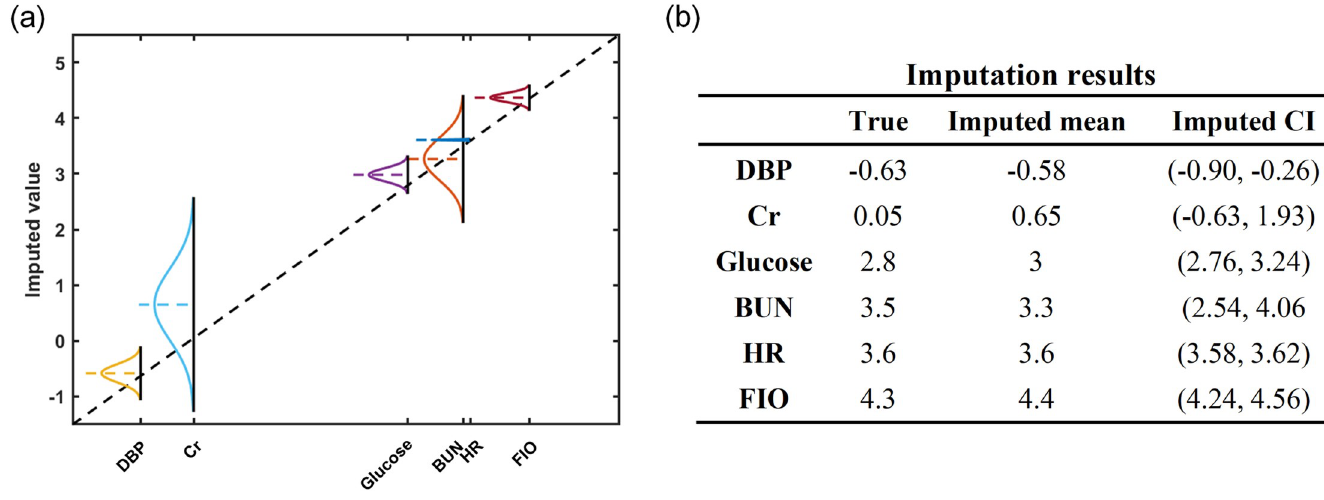
Fig 1. Imputed results of a single